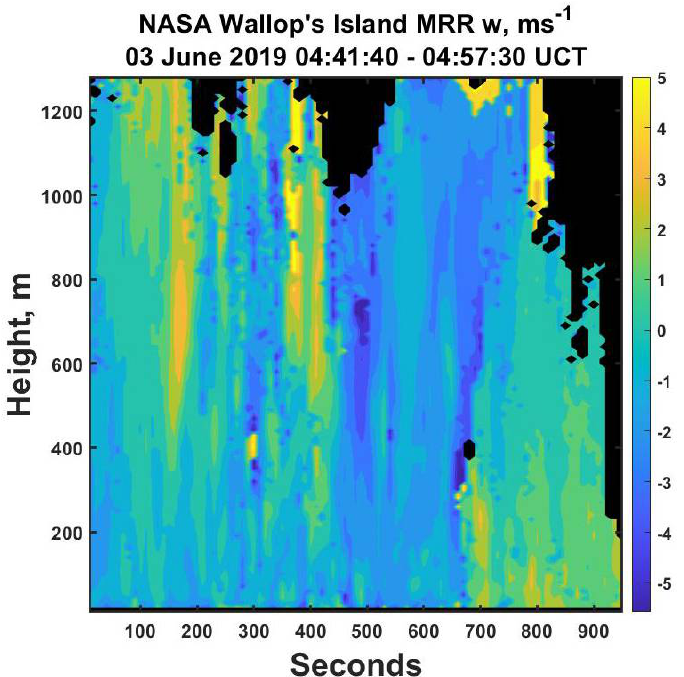
Figure 17. The air vertical velocities derived using the approach described in the text. Note the coherent but smaller scale temporal and spatial structure of the winds compared to those found in the later time period (Figure 11) likely reflecting the more convective nature of these data. Spectral folding occurred in a few locations leading to the enhanced velocity scale. The large black areas are due to a lack of power, while smaller ones are where no solutions were found without having to further process the